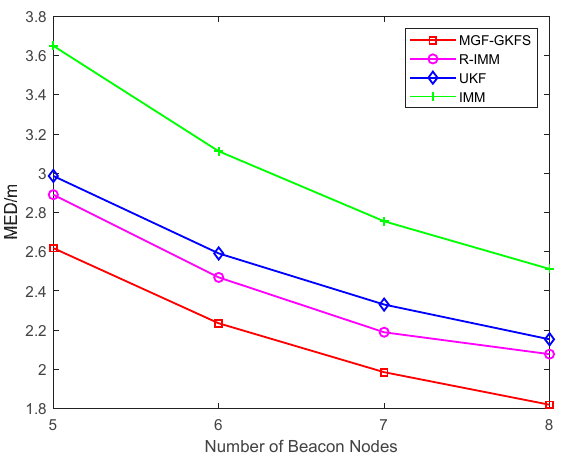
Figure 6. The mean error distance (MED) versus the number of beacon nodes.